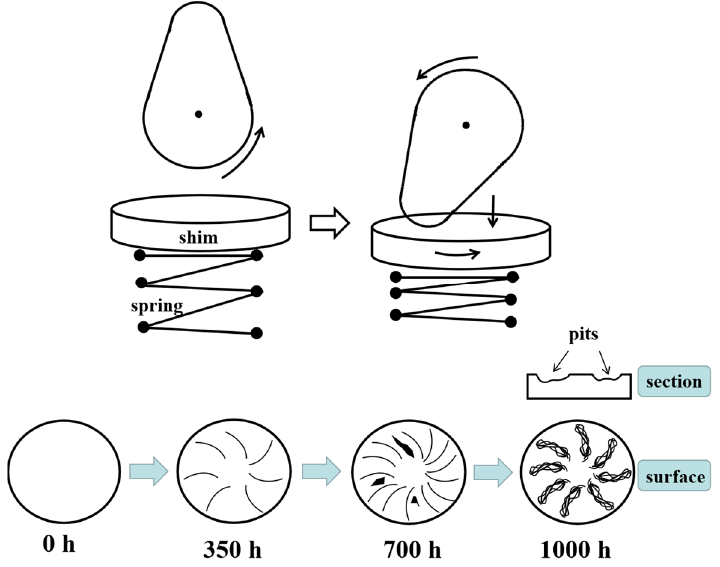
Figure 11. Schematic illustration of the wear process of shim against cam.